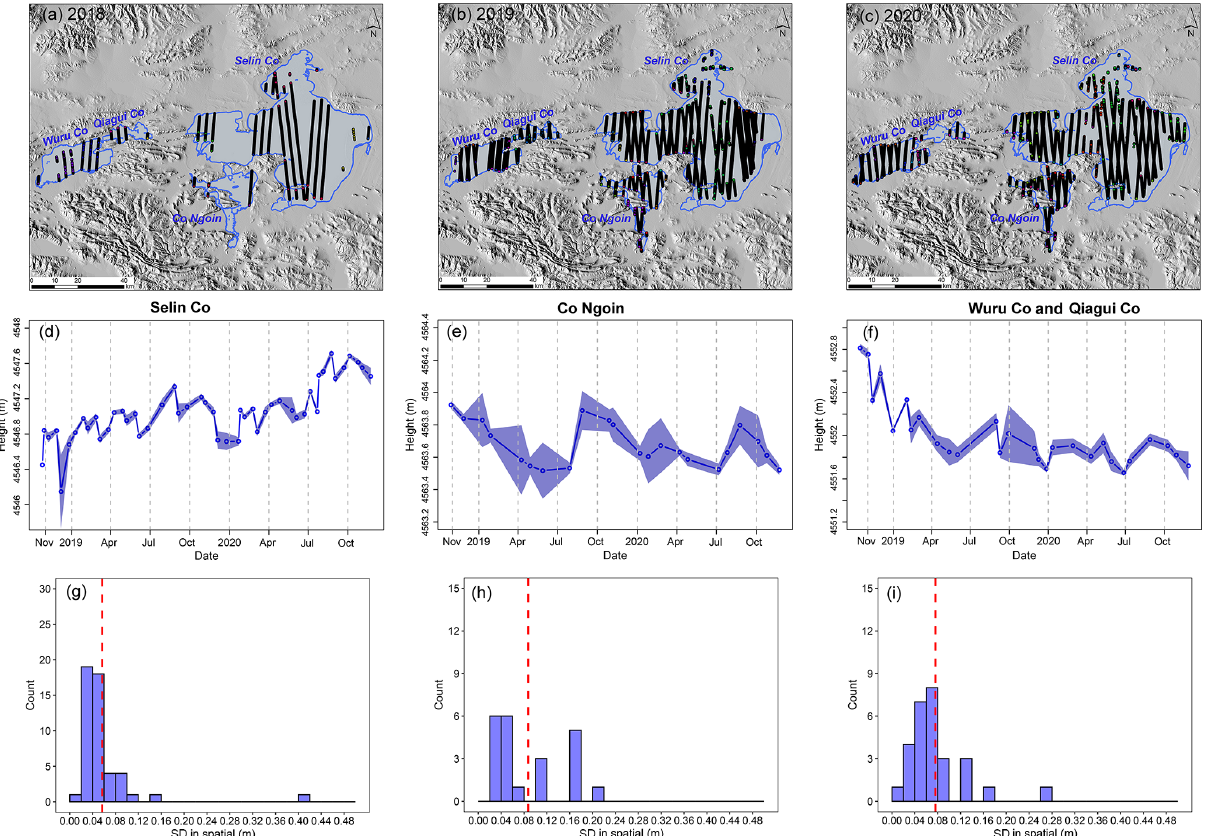
Figure 4. Water surface elevations of the three lakes. Panels (a) – (c) show tracks of the elevation measurements for each year. Panels (d) – (f) show the ICESat-2-derived elevations. The solid lines indicate the average values of all elevation measurements within the lake on a given date. The light-colored areas show the mean ± 1 standard deviation. Panels (g) – (i) further show histograms of the standard deviations of the water surface elevation of the lake from all acquisition dates. The dashed red line indicates the mean value. Table 3. Lake areas and surface water elevations. Lake elevations are presented as the mean ± 1 standard deviation of all elevation measure- ments of the lake within the year. The tracks of the ICESat-2 elevation measurements are shown in Fig. 4a–c. Selin Co Co Ngoin Wuru Co & Qiagui